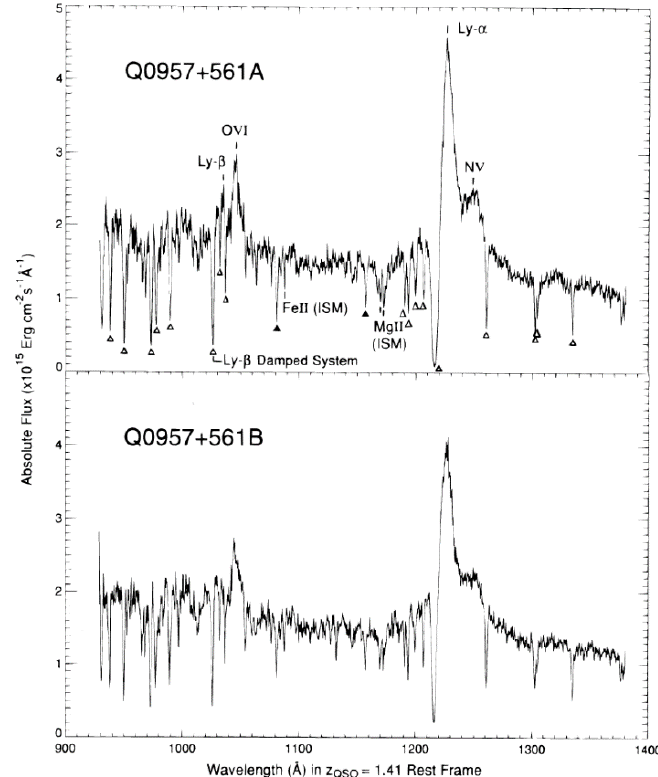
Figure 10. Spectra of the two images of the lens system QSO 0957+561, obtained with the Faint Object Spectrograph on board HST [84]. The strong similarities of the spectra, in particular the same line ratios and the identical redshift, verifies this system as a definite gravitational lens system. Image credit: [85].